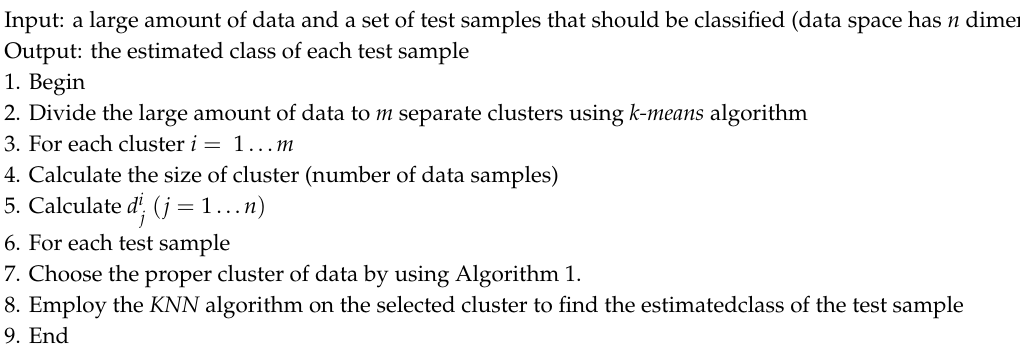
Algorithm 2. The proposed KNN for big